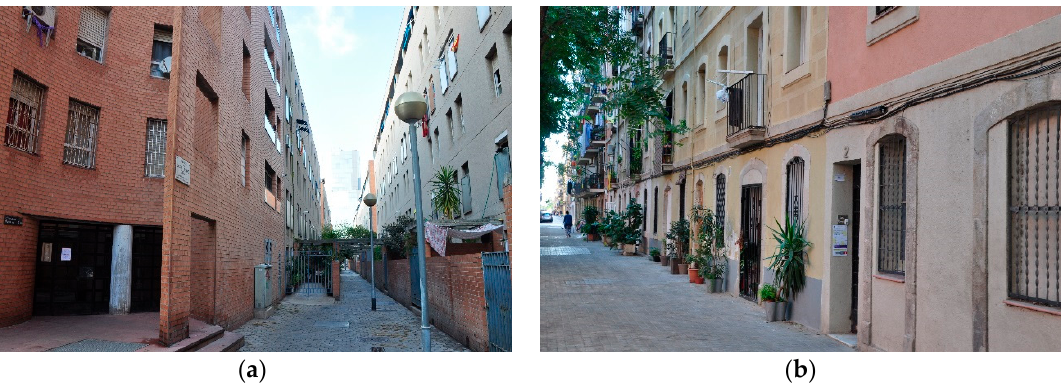
Figure 10. La Barceloneta: ( a ) social housing in MTM, and ( b ) small houses.